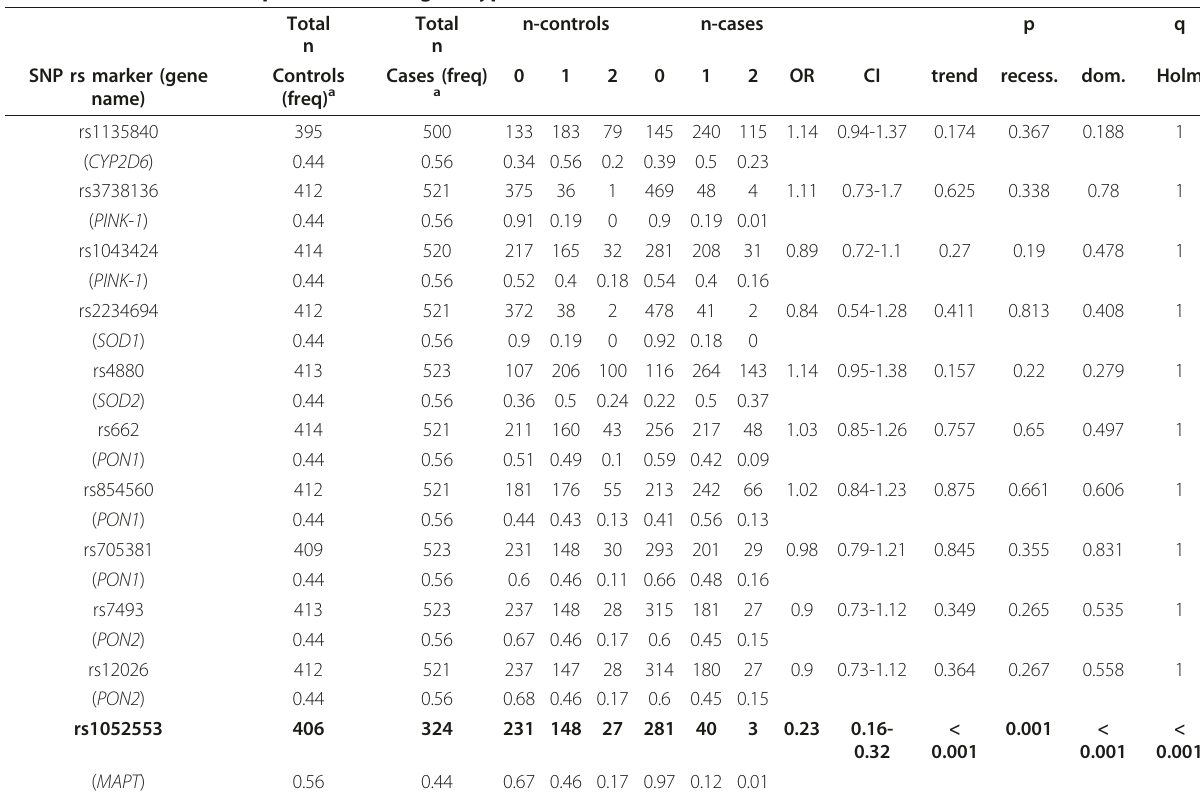
Table 2 Case-control comparison of SNP genotypes